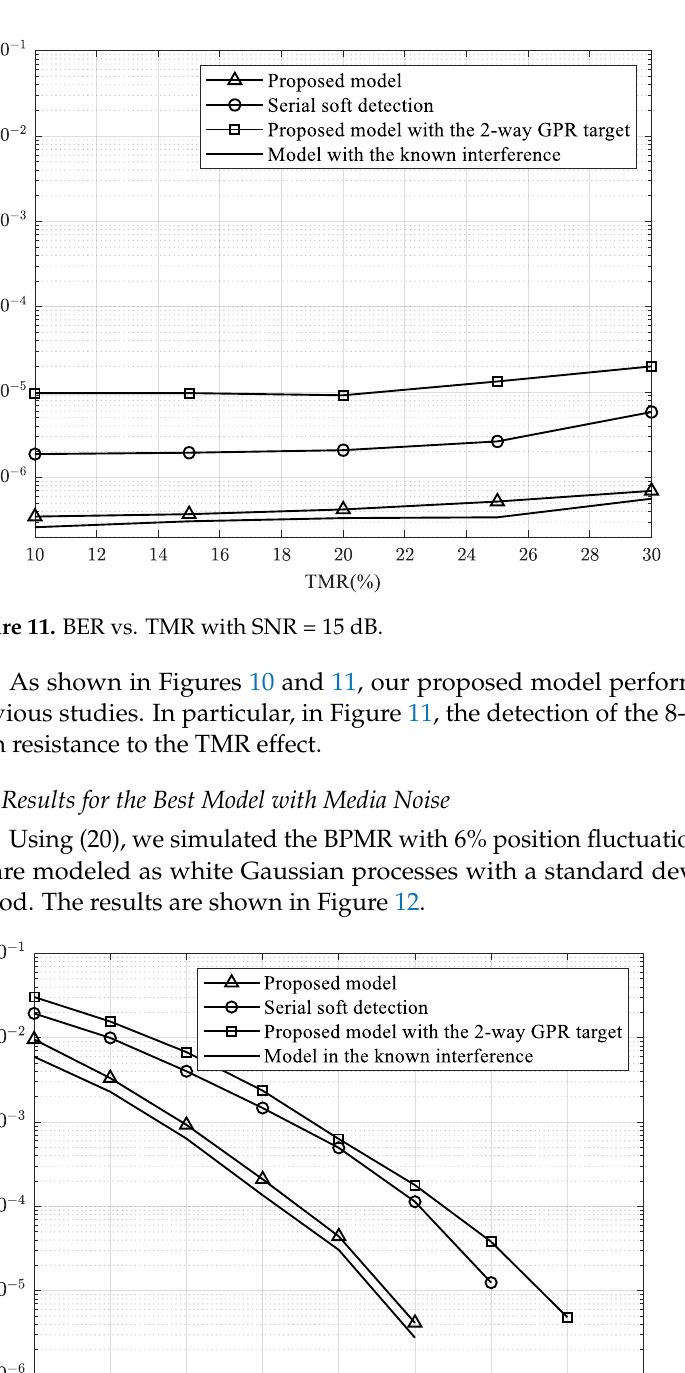
Figure 12. BER vs. SNR with 6% position fluctuation.